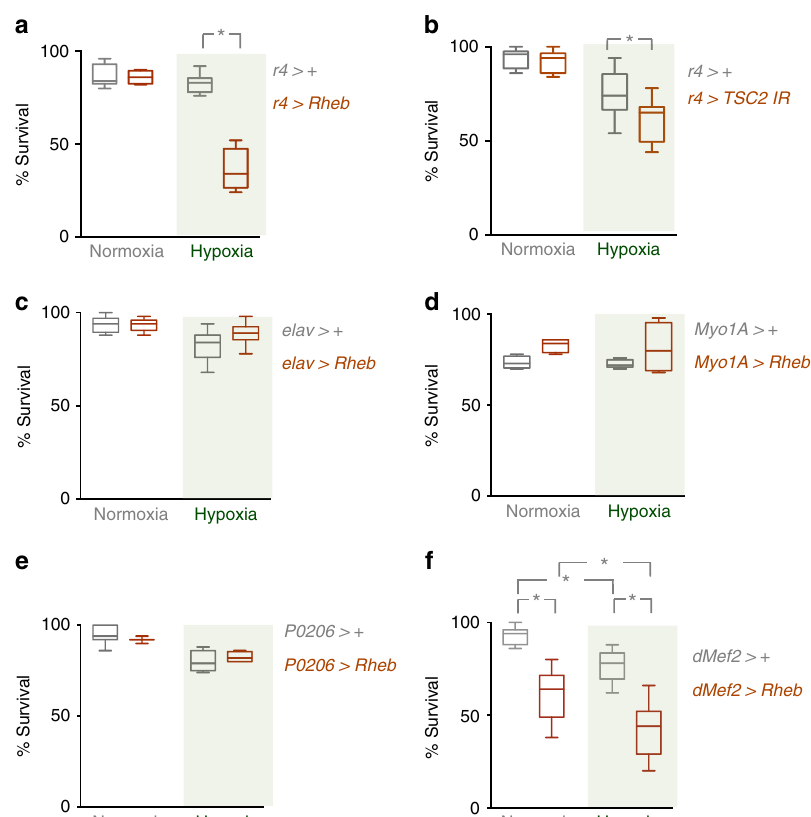
Fig. 4 Suppression of TORC1 in the fat body is required for adaptation to hypoxia. a Control ( r4 > + ) larvae or larvae overexpressing Rheb in the fat body ( r4 > Rheb ) were maintained in either normoxia or hypoxia (5% oxygen) throughout the larval period and then were returned to normoxia at the beginning of the pupal stage. The percentage of animals that survived to adults was then measured. Animals expressing Rheb in the fat body and exposed to hypoxia as larvae showed a signi fi cant decrease in adult survival. Data are presented as box plots (25%, median and 75% values) with error bars indicating the min and max values. N = a minimum of four groups (50 animals per group) per experimental condition. * p < 0.05, Students t -test. b Control larvae ( r4 > + ) or larvae expressing an inverted repeat RNAi transgene to TSC2 ( r4 > TSC2 IR ) were maintained in hypoxia throughout the larval period from hatching to pupation. Animals were then returned to normoxia and the percentage of animals surviving to the adult stage counted. Data are presented as box plots (25%, median and 75% values) with error bars indicating the min and max values. N = 6 groups of animals (50 animals per group) per experimental condition. * p < 0.05, Students t -test. c – e Rheb was overexpressed in larval neurons ( c , elav > Rheb ), the intestine ( d , MyoIA > Rheb ), the prothoracic gland ( e , P0206 > Rheb ) or muscle ( f , dmef2 > Rheb ). Animals were hatched in normoxia and then maintained throughout the larval period in either normoxic or hypoxic conditions, before being returned to normoxia at the pupal stage. The percentage of animals that survived to the adult stage was calculated for each experimental condition. Control animals carried the Gal4 transgene alone. Data are presented as box plots (25%, median and 75% values) with error bars indicating the min and max values. N = a minimum of four independent groups of animals (50 animals per group) per experimental condition. * p < 0.05, Students